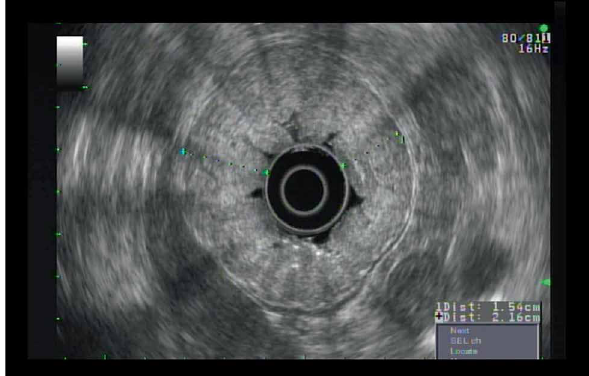
Figure 3: Endoscopic ultrasound showing wall thickening was seen in the body of the stomach. The thickening appeared to be primarily within the sub mucosa (Layer 3), >1